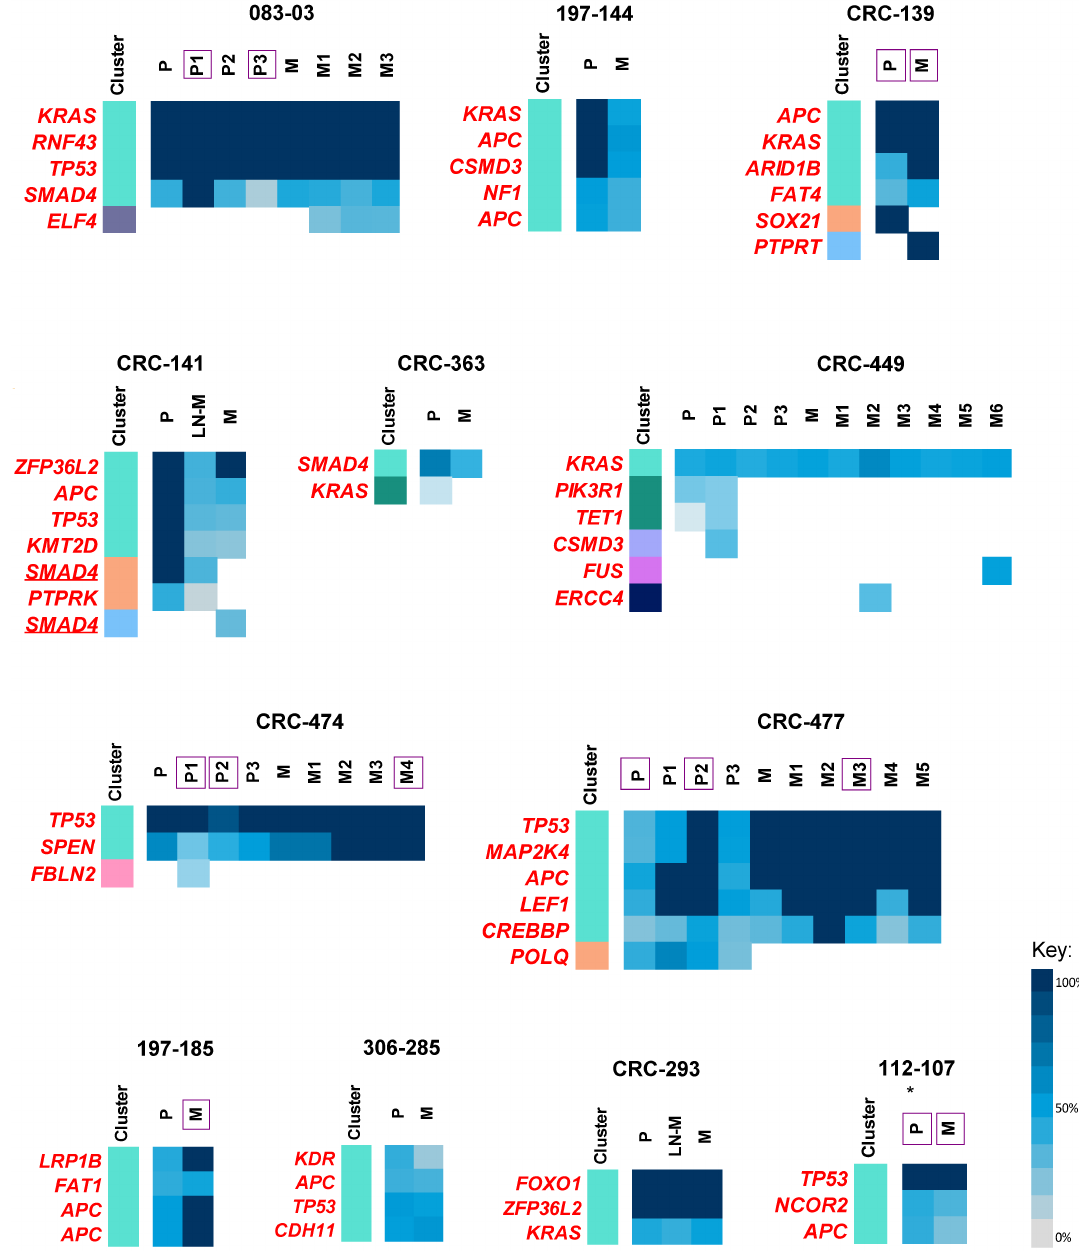
Figure 4. Therapy resistance in treated metastatic colorectal cancer (CRC) samples. Coloured bar represents mutation clusters, with corresponding %cancer cell fractions (%CCF) of each clustered driver mutation as a heatmap. The underlining represents individual parallel mutations converging at the same gene. Tumour regions with genome doubling are indicated with purple squares. “P” refers to primary CRC tumour, “LN-M”, refers to lymph node metastasis, and “M”, refers to the distant metastatic lesion, with multiple spatially distinct regions numbered accordingly, where relevant. The treatment status of the primary tumour of patient 112-107, marked by an asterisk (*), was not